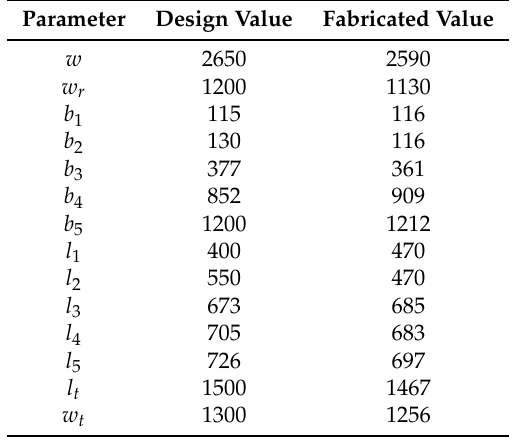
Table 2. Dimensions of the first transition model; see Figure 1a for reference. All dimensions in µ m.